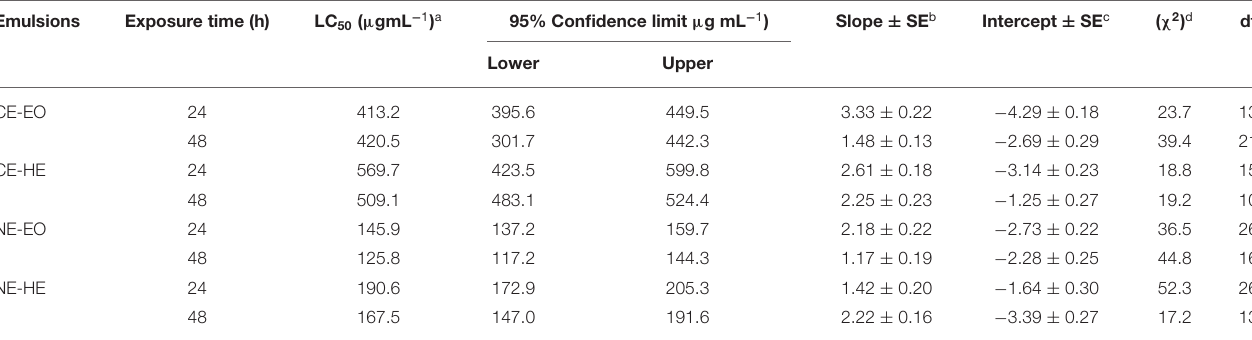
TABLE 5 | Contact toxicity of CEs and NEs against third instar larvae of S. litura using leaf dip assay after 24 and 48h.